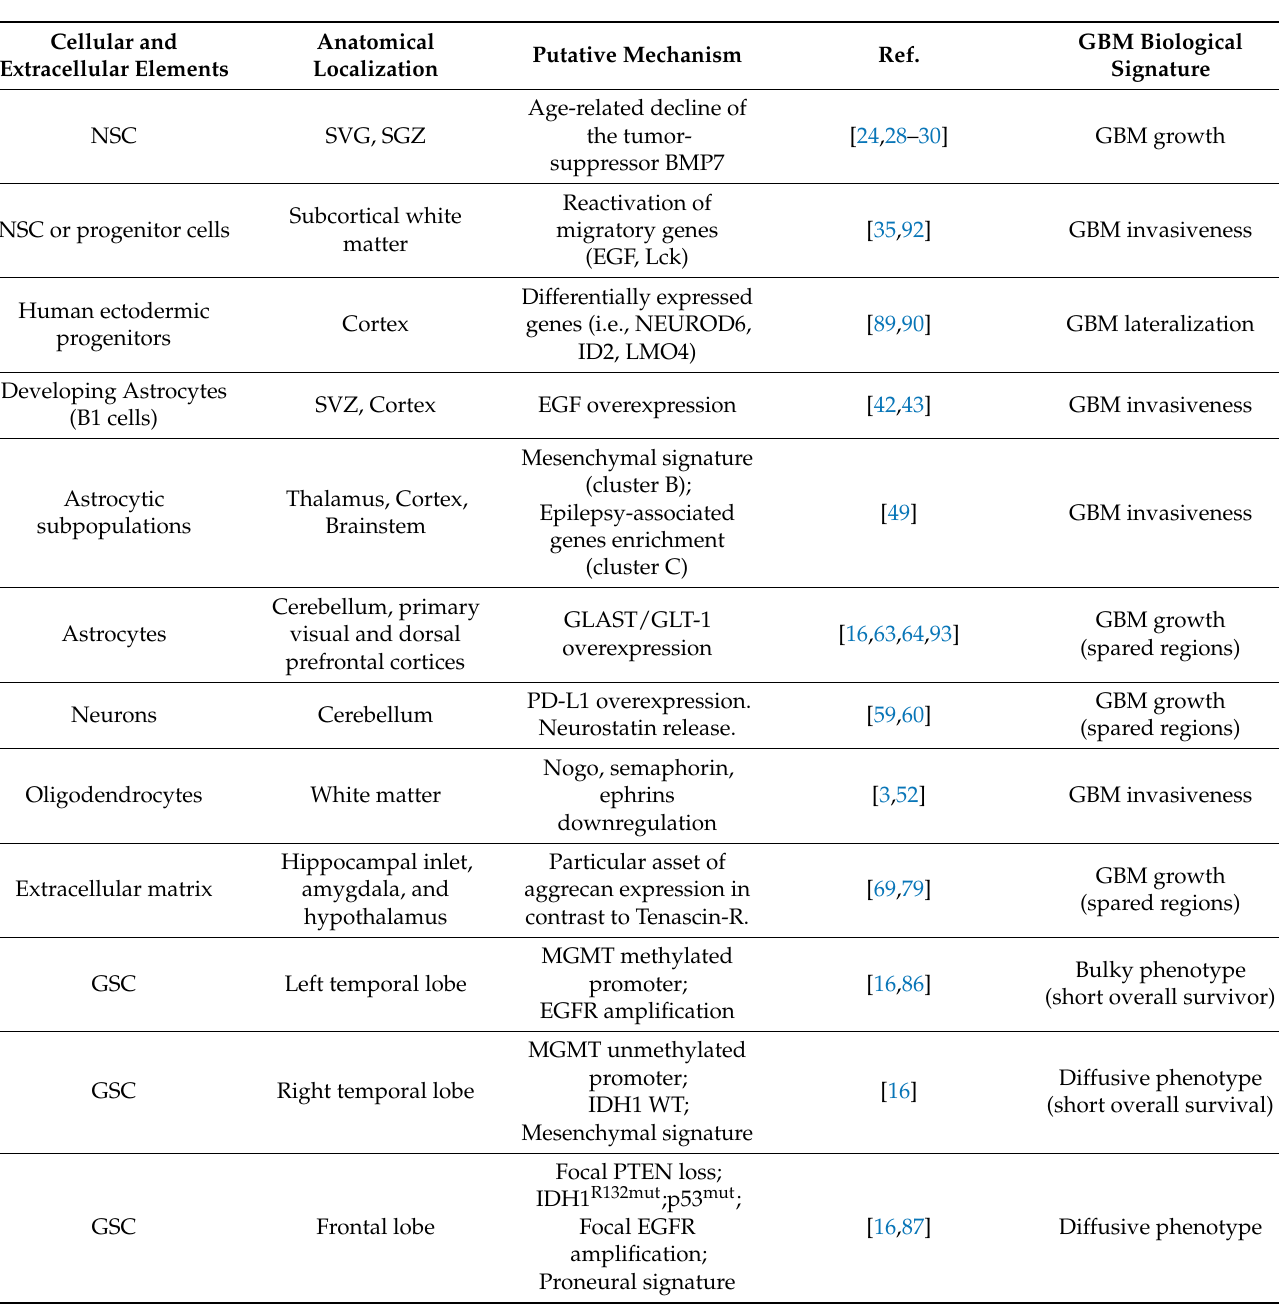
Table 1. Cellular and extracellular elements with the putative molecular mechanisms that could determine the biological signature of GBM, according to a specific anatomical localization. ECM: extracellular matrix; GSC: glioma stem cell; NSC: neural stem cell; SGZ: subgranular zone; SVZ: subventricular